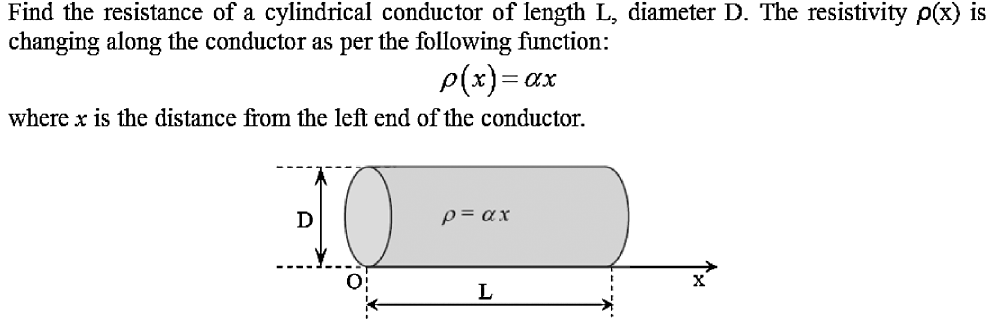
FIG. 3. The cylindrical conductor problem (interview